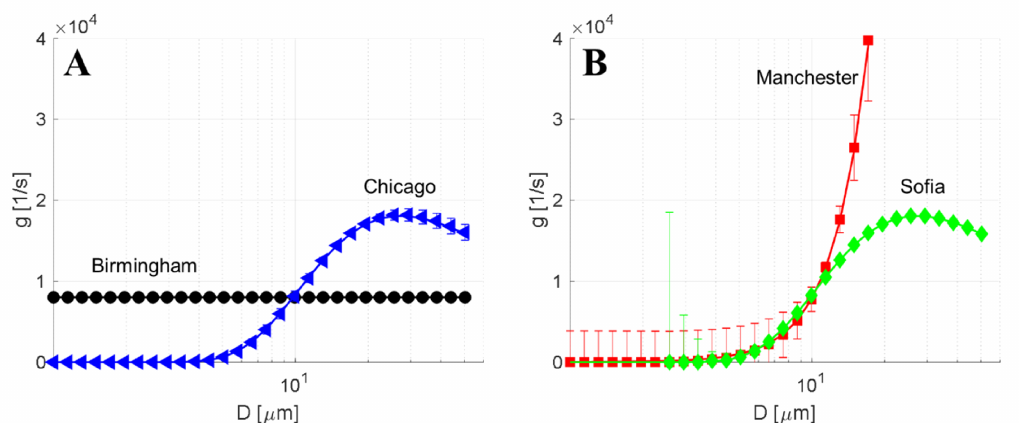
Figure 2. Comparing estimated (symbols) and set (solid lines) fragmentation rates ( g ), as functions of drop size, D, for the four methods. All estimations are made on DSD data containing a relative uncertainty of 4%. Error bars denote resulting expanded uncertainty in g obtained, ( A ) The Chicago Method and The Birmingham Method, ( B ) The Manchester Method and The Sofia